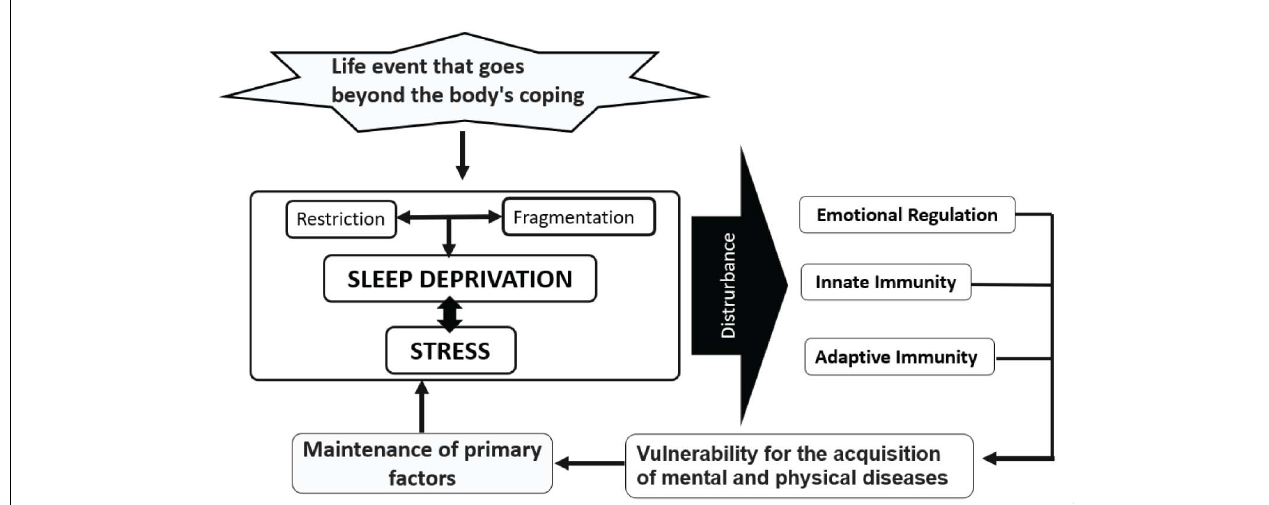
FIGURE 1 | Model of vulnerability and maintenance of the disease due to sleep deprivation and stress (source authors). It can be seen how stressful events that exceed the body’s ability to respond to them generate sleep deprivation and stress; these last two factors form a relationship that occurs in a bidirectional way because one can be the cause of the other. Regarding sleep, it can be affirmed that the causal relationship of deprivation can be facilitated by voluntary and involuntary restriction of the subject or by fragmentation of the same or both factors, which cause sleep deprivation to increase. As a result of this interaction, the alteration of emotional regulation and the immune response, both acquired and adaptive, arises, which puts the subject, after the alteration of said factors, at greater vulnerability for the acquisition of mental and physical diseases, which increases the primary factors of stress and sleep deprivation, which is not linear and can create a perpetuation of these problems or the acquisition of diseases such as COVID. This demonstrates the importance of prevention measures in healthcare